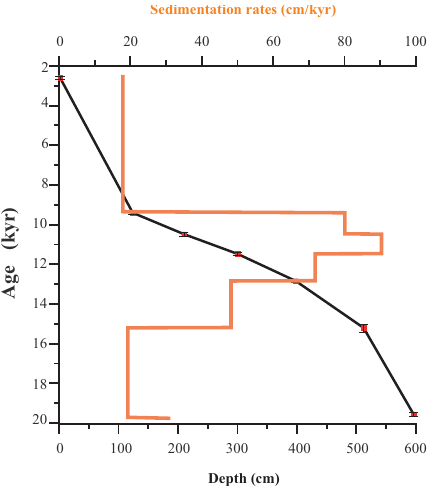
Figure 3. Calibrated age–depth relation for core GeoB12624-1 (bars indicate the 1 σ error range; yrBP) and sedimentation rates (cmkyr − 1 ; orange line).